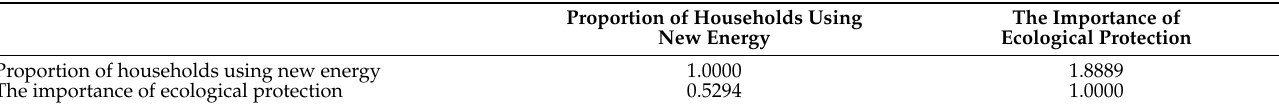
Table A10. C6–D: Judgement matrix of the sustainability of ecological protection.